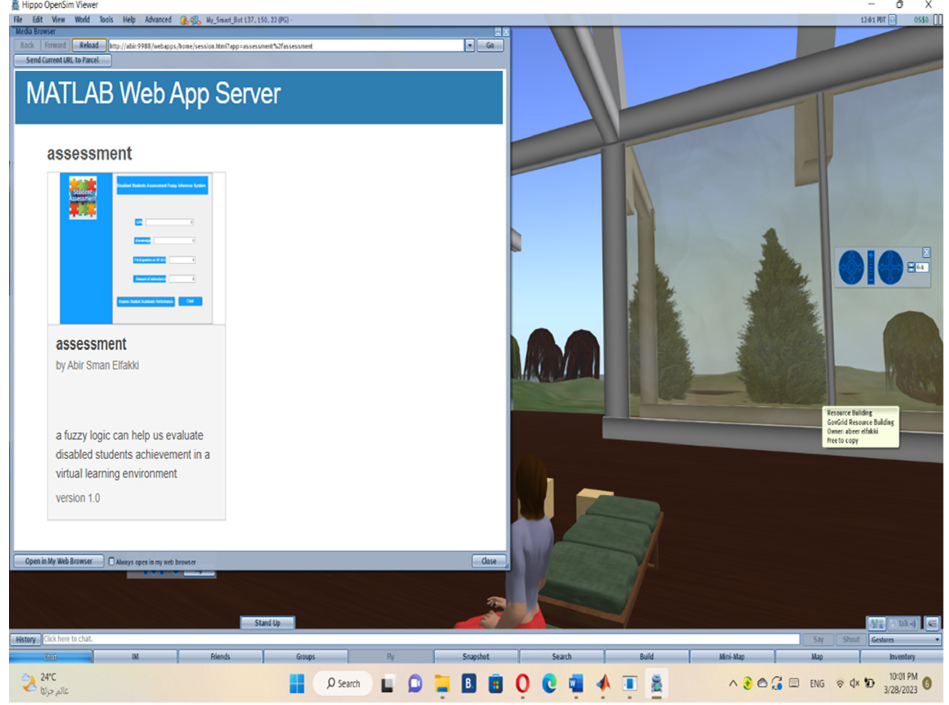
Figure 12. Present FIS embedded within the 3D VLE.